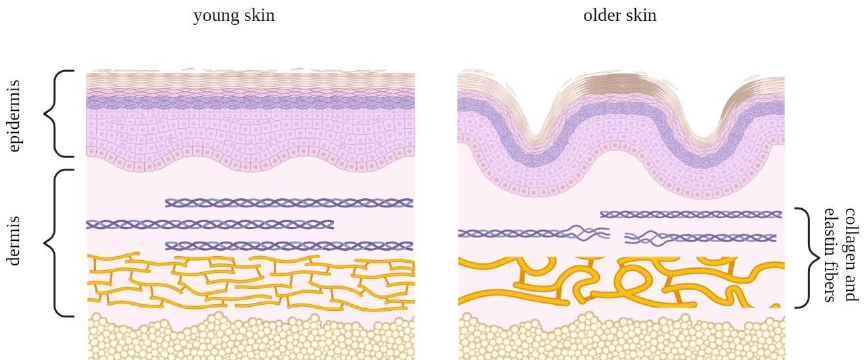
Figure 6. Schematic comparison of young skin ( left panel ) and skin undergoing aging transformation ( right panel ). The epidermal layer comprises keratinocyte cells and consists of five sections: the horny layer, stratum lucidum, granular layer, spinous layer, and basal layer. Collagen and elastin fibers lie underneath these layers in the dermis. These fibers play a role in the rigidity and elasticity of the skin and, with time, are subject to deterioration, leading to the loss of structural uniformity in the skin.